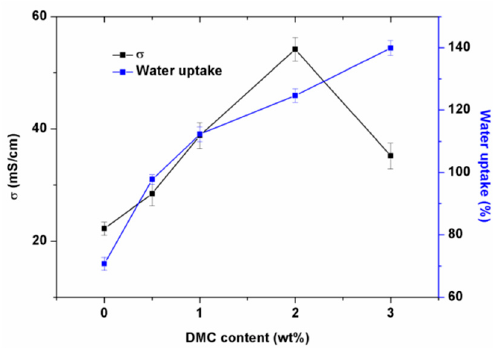
Figure 5. Ionic conductivity and water uptake versus the DMC content measured at room temperature.